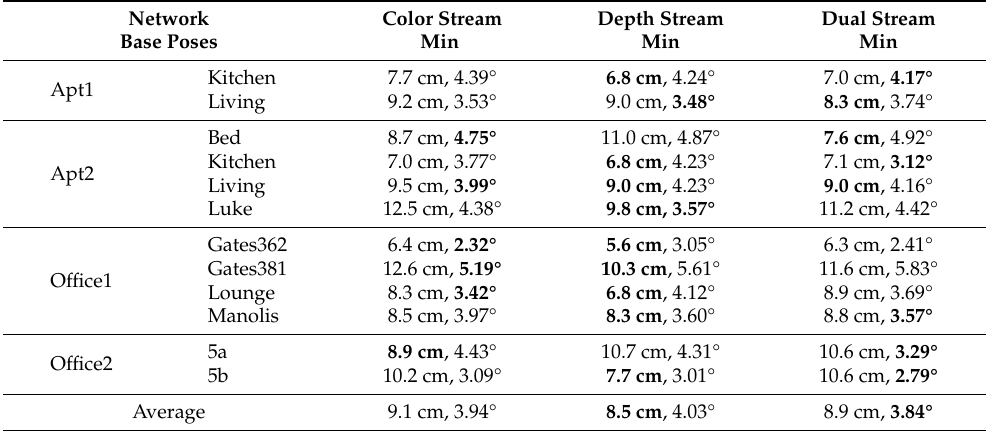
Table 9. Median translation error (cm) and rotation error (°) for different network architectures on 12 Scenes . Bold numbers indicate the lowest error